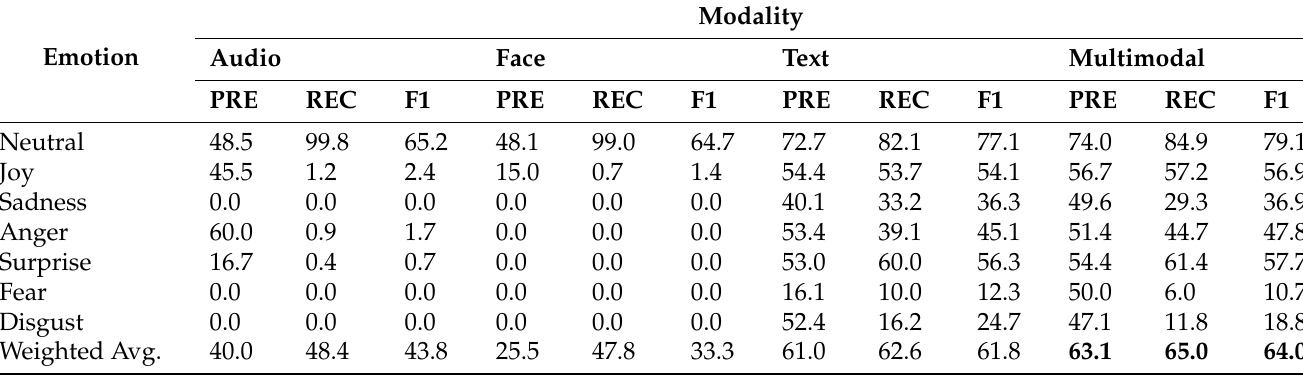
Table 1. The performance of the classification results for the MELD (PRE: Precision, REC: Recall, F1: F1-score) (Unit = %).